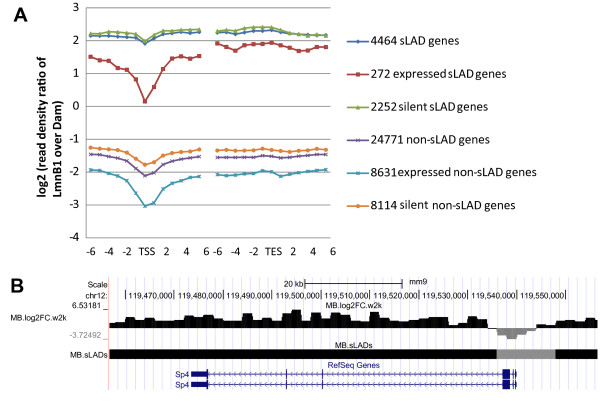
Nuclear lamina association profiles across genic regions. (A) The entire set of 29235 genes was assigned to two groups: sLAD genes and non-sLAD genes. Among them, 19269 genes with expression data [32] were further assigned to four subgroups: expressed sLAD genes, silent sLAD genes, expressed non-sLAD genes and silent non-sLAD genes. Log2 seq ratios of genes in the same group were aligned using the 2 kb windows containing TSSs and TESs respectively, and the average log2 seq ratios of the six 2 kb windows upstream, the window containing TSSs/TESs and the six 2 kb windows downstream were plotted. (B) A genome browser view of the Sp4 gene expressed in C2C12 myoblasts and its NL association status.